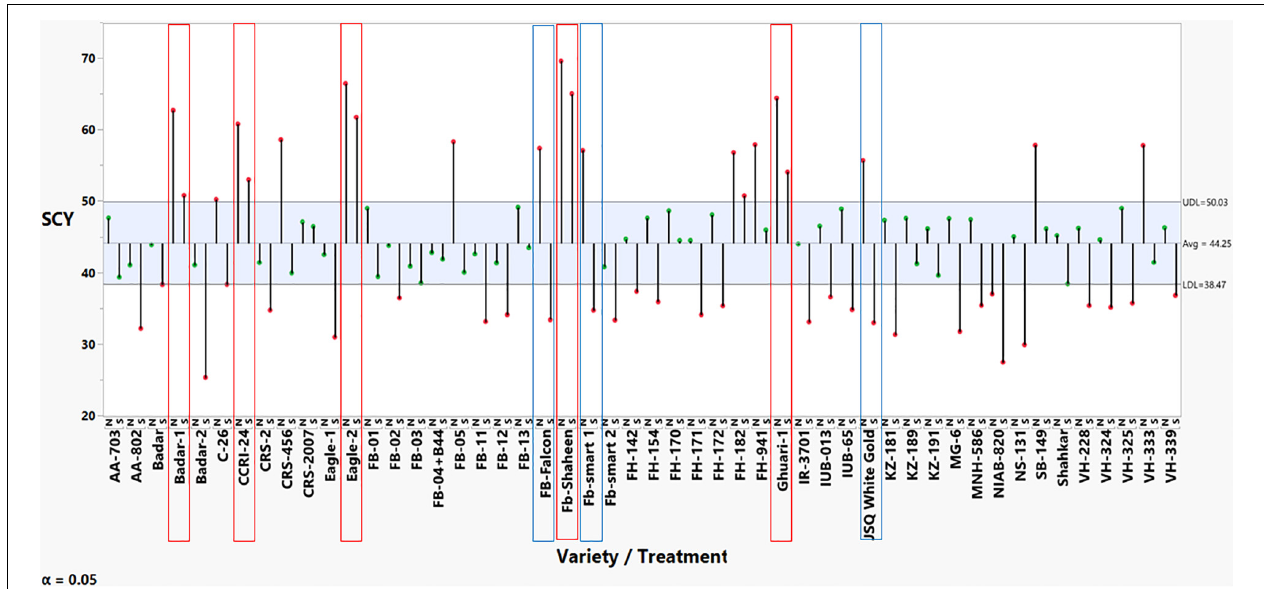
FIGURE 1 | ANOM-decision chart with decision limits 38.47–50.03 for seed cotton yields across normal and heat stress (alpha > 0.05%). It provides a graphical test for simultaneously comparing the mean performance of these 50 cotton genotypes across normal and heat stress. Red-colored heads represent significant deviation from the mean, either above upper decision level (UDL) or below lower decision level